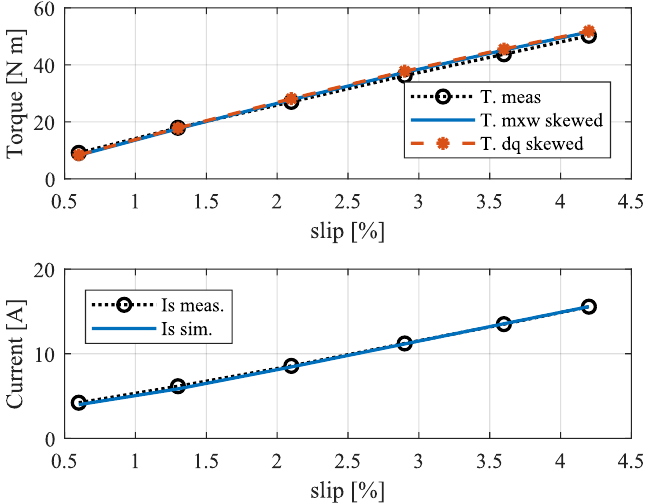
Figure 11. Measurements comparison about average torque and stator current. The measurements have been carried out according to the standard for grid-connected IMs’ efficiency computation: keeping constant the voltage, the load is increased from 25% to 150% of the rated